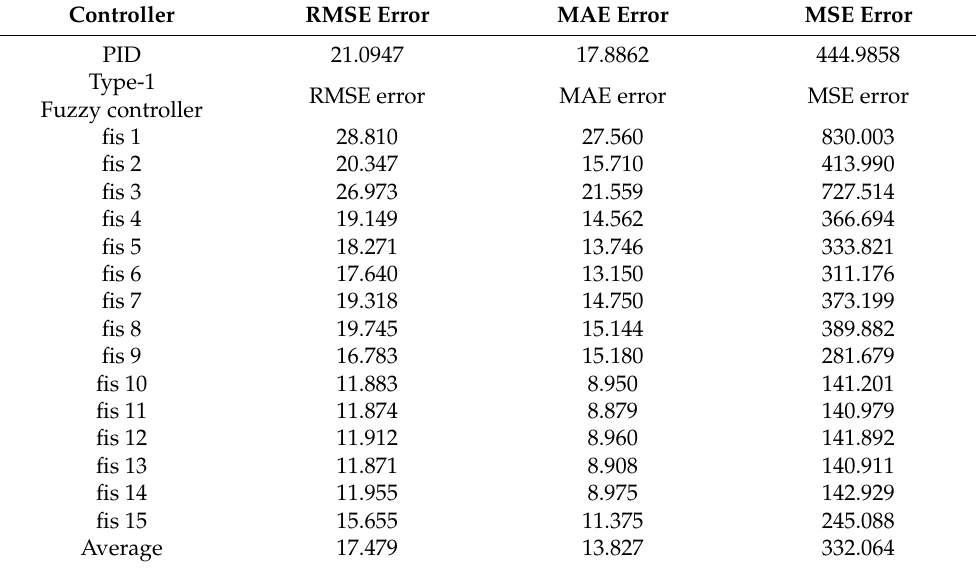
Table 1. Results for the PID and type-1 fuzzy control for optimal supply of